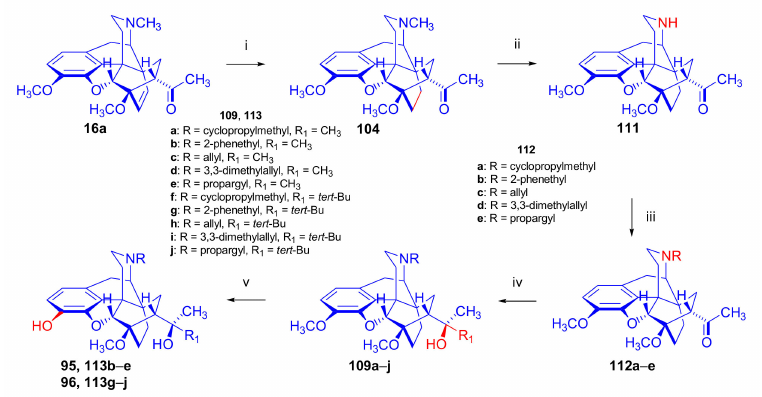
Figure 35. Synthesis of N 17 -substituted-diprenorphine and buprenorphine analogues. Reagents and conditions : (i): H 2 , Pd-C, toluene, 55 ◦ C, 6 bar; (ii): (1) DEAD, benzene, reflux, 8 h, (2) pyridine hydrochloride; (iii): RBr, NaHCO 3 , 90–95 ◦ C, 20 h; (iv): R 1 MgX, toluene-THF or diethyl toluene-ether; and (v): KOH, diethylene glycol, 210 ◦